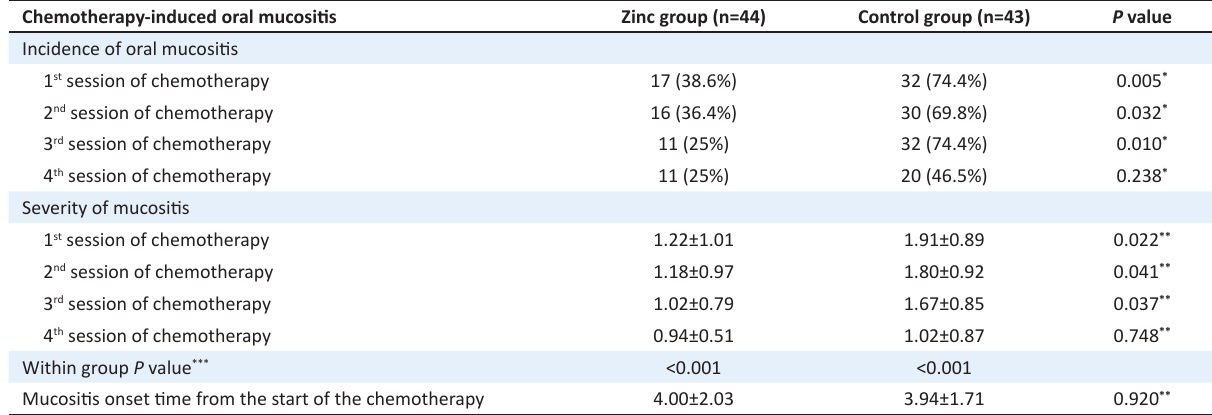
Table 2. The incidence of chemotherapy-induced oral mucositis in the two groups Chemotherapy-induced oral mucositis